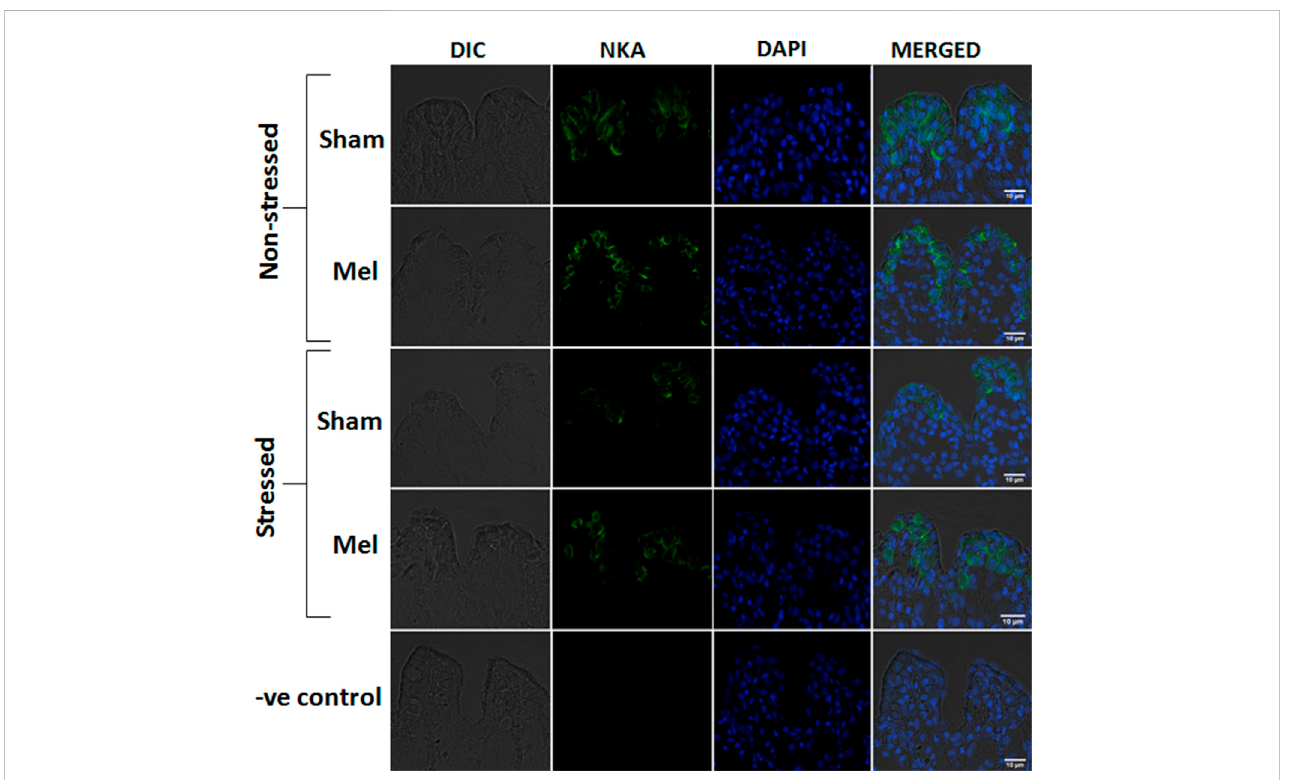
FIGURE 10 Confocalimagesofimmuno fl uorescencestainingofNKA α -subunitinthesecondarylamellaeofgillsaftermelatonin(Mel)treatmentinnon-stressedand immersion stressed (IMR) climbing perch. Gill fi laments were incubated with mouse monoclonal Na + /K + ATPase α 1 antibody (green) and nuclear stain DAPI (blue). Branchial ionocytes with rich NKA α 1-immunoreactivity are seen located in the secondary lamellae and their distribution pattern and intensity are modi fi ed after melatonin treatment in non-stressed and immersion-stressed fi sh. Each panel starts with DIC (differential interference contrast) image, fl uorescence images of NKA α 1 (green) and DAPI (blue) and a merged image in DIC. The last panel shows the corresponding images of negative control in which the incubation with primary antibody was omitted. Scale bar 10 μ